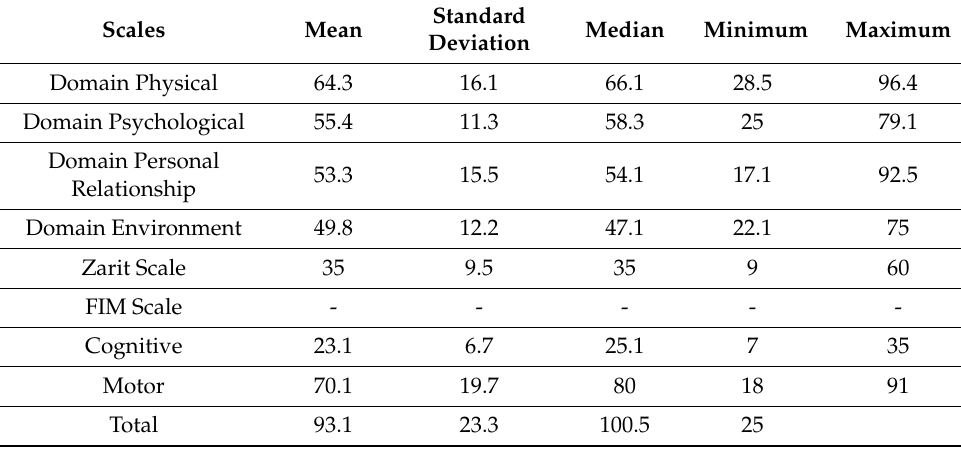
Table 3. Sample distribution based on assessment of caregivers’ WHOQOL-bref domains, ZBI scale and FIM result.